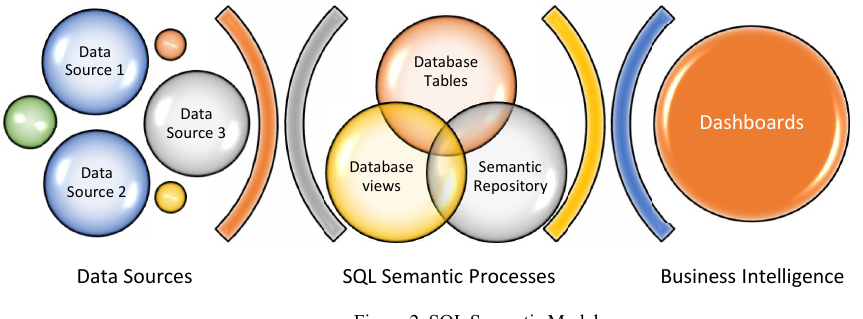
Figure 2. SQL Semantic